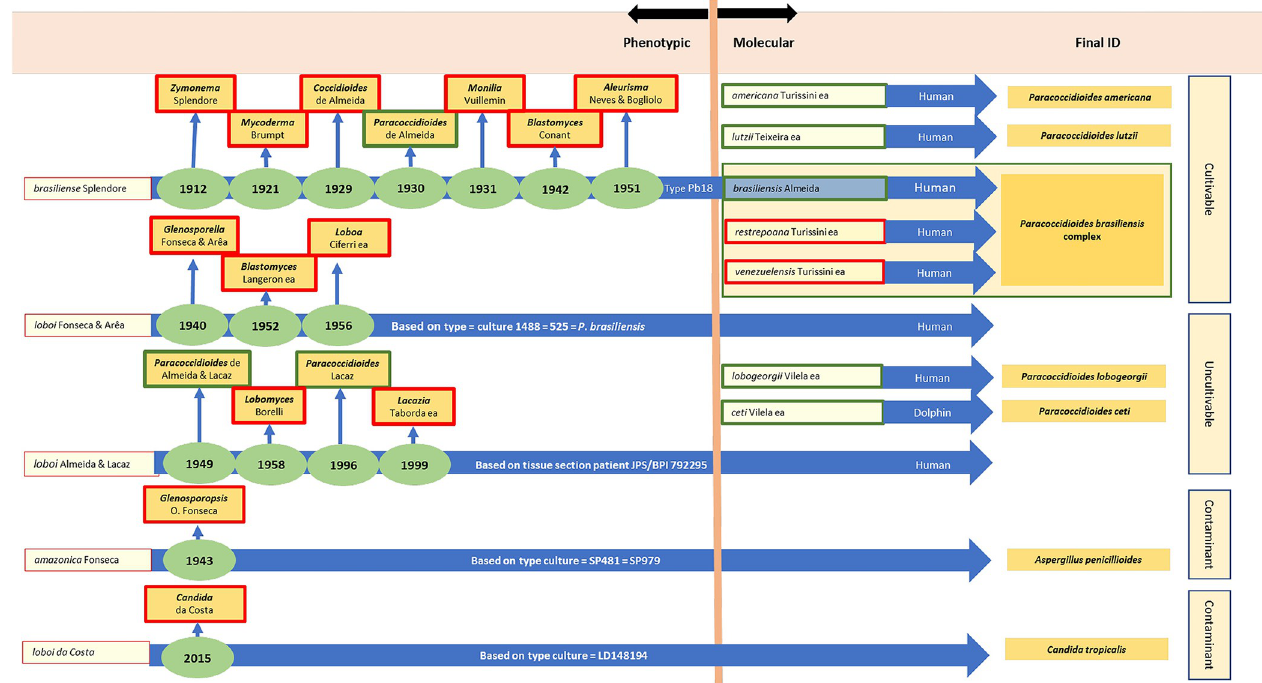
Fig 3. Phenotypic and molecular events in the taxonomy of Paracoccidioides species. Phenotypic and molecular features used to justify the different binomials given to the etiologic agents of Lutz’s and Jorge Loˆbo’s diseases involving cultivable and uncultivable Paracoccidioides species. The left chart depicts the synonyms utilized across the years for both diseases, giving the names and type culture used to justify their names (for P . lobogeorgii usually contaminant fungi), as well as the years when the binomials were first introduced. The current accepted taxon for the etiologic agents of both diseases is shown within green rectangles, whereas invalid names appeared within red rectangles as per Vilela and colleagues